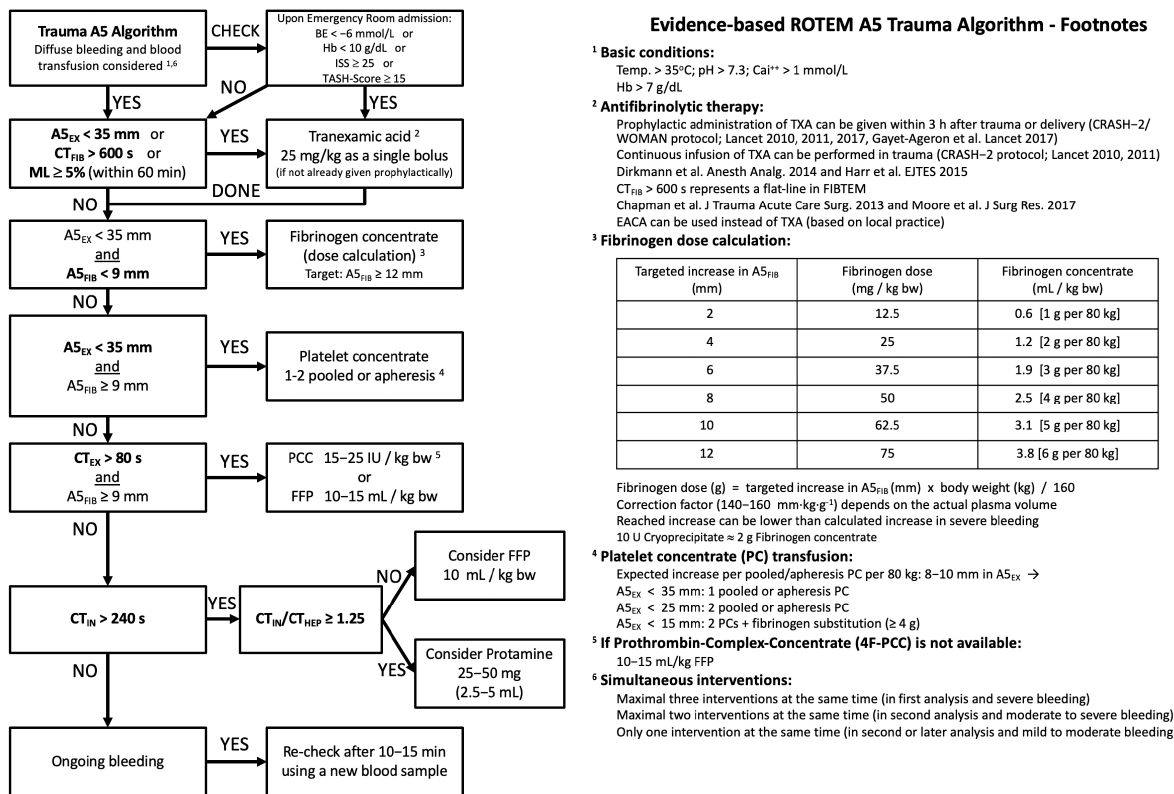
Figure 5. Exemplar algorithm to guide hemostatic therapies by the use of functional viscoelastic testing results (ROTEM ® ) successfully implemented at centers formerly naïve to this technology. Test results were available for clinical decision-making within a median of 15 min of blood sampling. When the algorithm recommended specific interventions and was followed, thromboelastometric test results improved significantly by the second blood sampling performed 30–60 min after decision- making and at least 10 min after the intervention (adapted from [66]). A10 = Clot amplitude after 5 and 10 min (in mm); CT = Clotting time (in seconds); Ex = ROTEM ® EXTEM assay; FFP = Fresh Frozen Plasma; Fib = ROTEM ® FIBTEM assay; g = gram; IU = International Units; ML = Maximum lysis (in percent); PCC = Prothrombin Complex